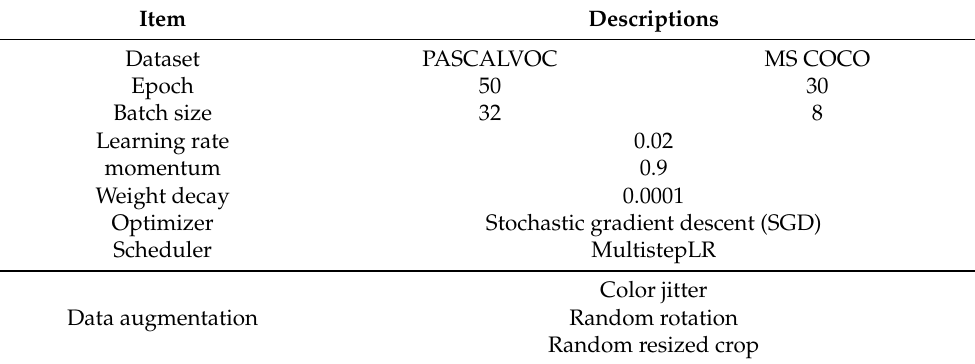
Table 1. Implementation details.